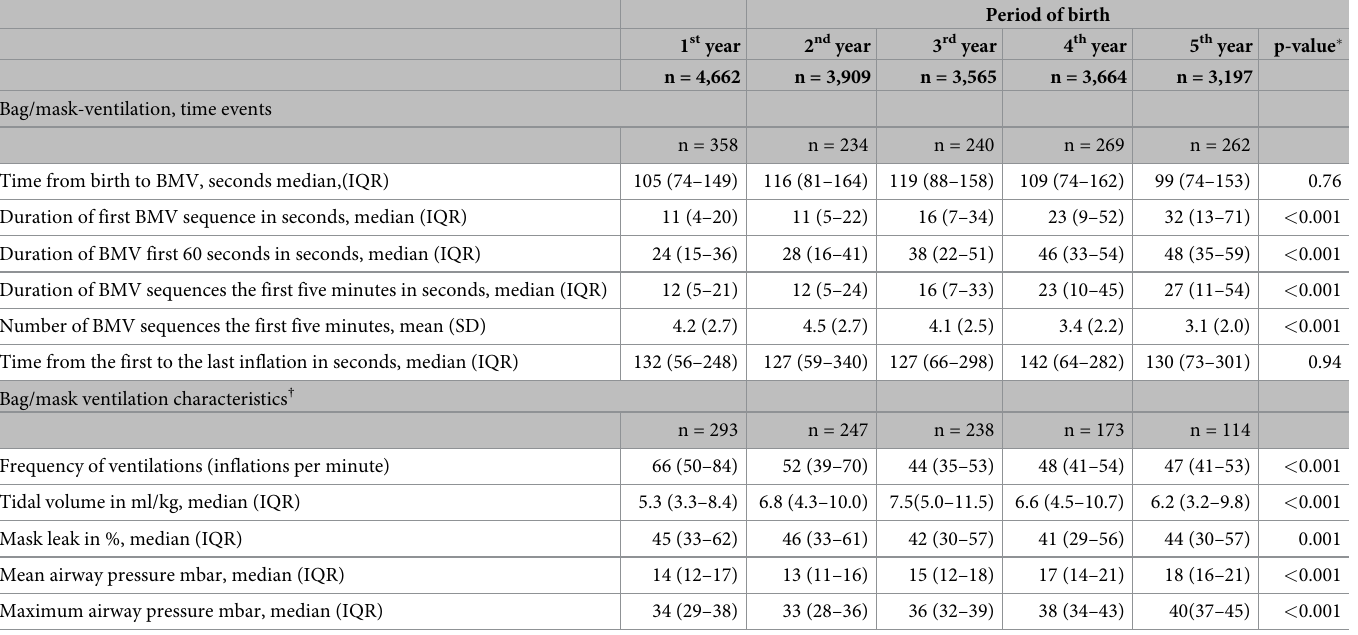
Table 5. Bag-mask ventilation characteristics of live births at Haydom 1.7.2013–30.6.2018 (n =